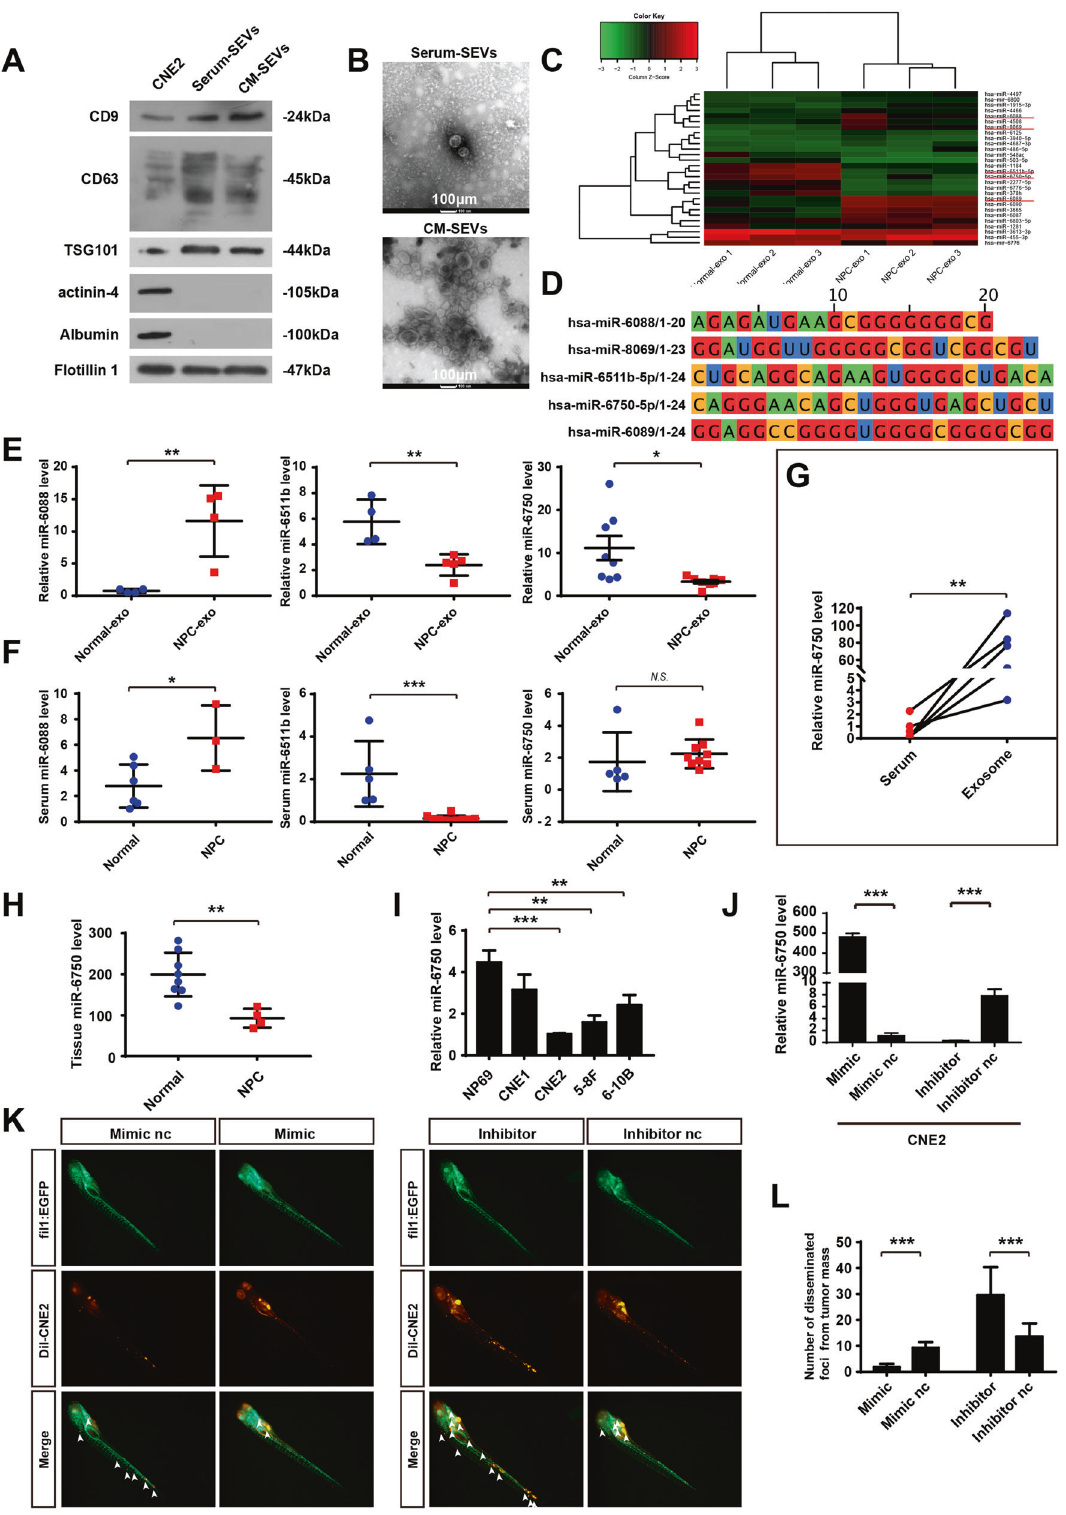
Fig. 1 MiR-6750 is speci fi c down-regulated in NPC-SEVs and inhibits NPC metastasis. A Western blot analysis of CD63, CD9, TSG101, Albumin, actinin-4 and Flotillin 1 in CNE2 cell line and SEVs. B Representative electron microscopy image of SEVs. C genome-wide analysis of miRNA expression in NPC-SEVs vs. healthy volunteers. D The sequences of miR-6088, miR-8069, miR-6511b, miR-6750 and miR-6089. E , F Levels of miR-6088/6511b/6750 in serum-SEVs and serum were measured by qRT-PCR. G Levels of miR-6750 in serum-SEVs vs. serum. H , I Levels of miR-6750 in NPC tissues and cells. J Transfection ef fi ciency was measured by qRT-PCR. K Gross-observation tumor cell dissemination and metastasis. CNE2 cells with different miR-6750 level labeled with Dil were injected into zebra fi sh embryos. 2 days later, migration of CNE2 cells was measured by fl uorescence microscopy. Arrowheads indicate disseminated tumor foci. L Quantitative evaluation of NPC cell dissemination and metastasis. Student ’ s t-test, mean ± SEM. Cell Death Discovery (2023)